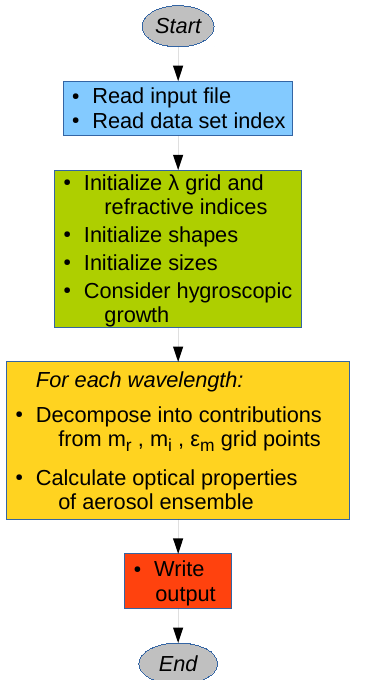
Figure 3. Simplified flow chart of the MOPSMAP Fortran